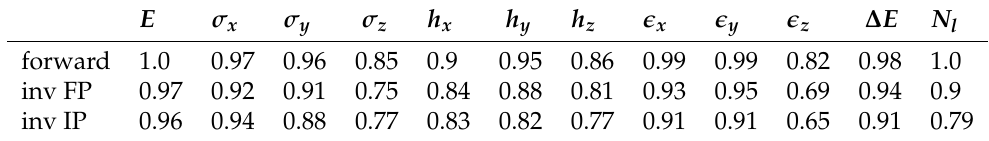
Figure A1. Percentiles of the relative prediction error for each quantity predicted by the forward IsoDAR model. Table A1. ¯ R 2 values of the IsoDAR models. The values of the row “inv FP” refer to the forward prediction of the invertible model, whereas the values in “inv IP” refer to its inverse prediction. The latter ones are calculated with the help of the forward